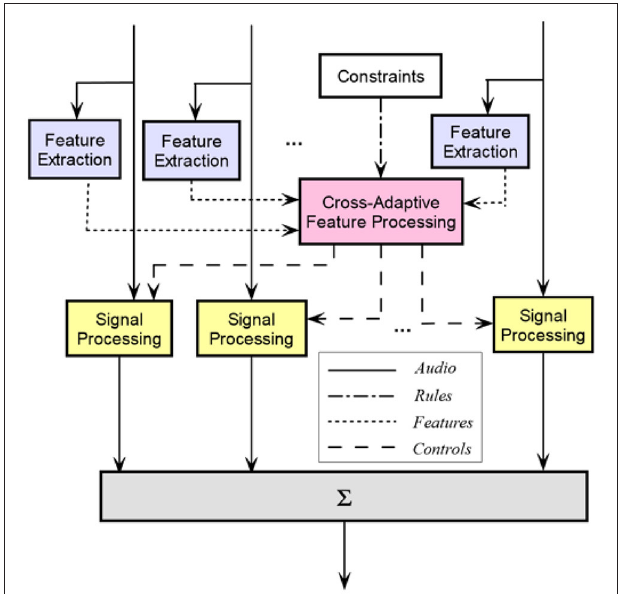
FIGURE 6 | An intelligent cross-adaptive mixing system. Extracted features from all inputs are sent to a single feature processing block where controls are produced. The outputs are summed to produce a mix that depends on the relationships between inputs. FIGURE 7 | Timeline of prior work